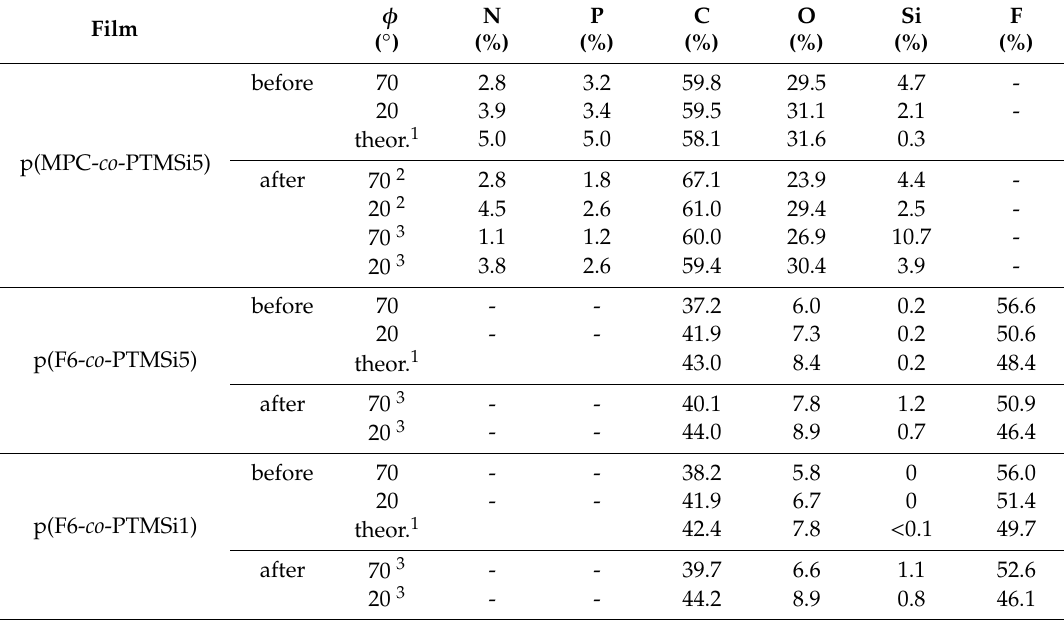
Table 2. AR-XPS atomic surface percentages of p(MPC- co -PTMSi5) and p(F6- co -PTMSix) before and after immersion in